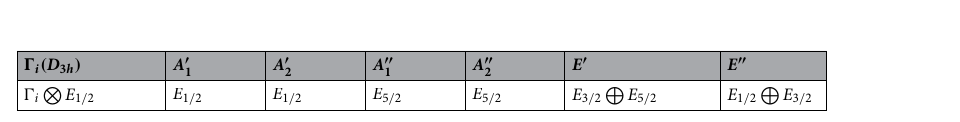
Table 3. Double-group IRs obtained from single-group IRs for D 3 h group.